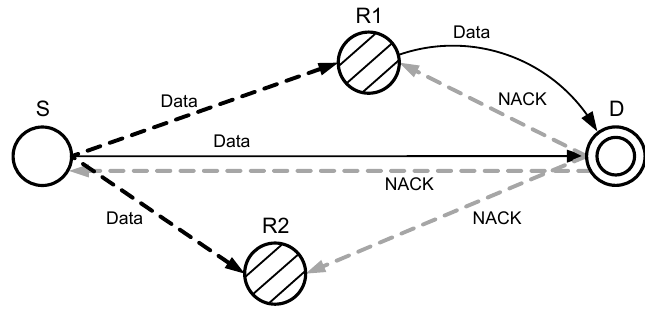
Figure 9. Data packet transmission with